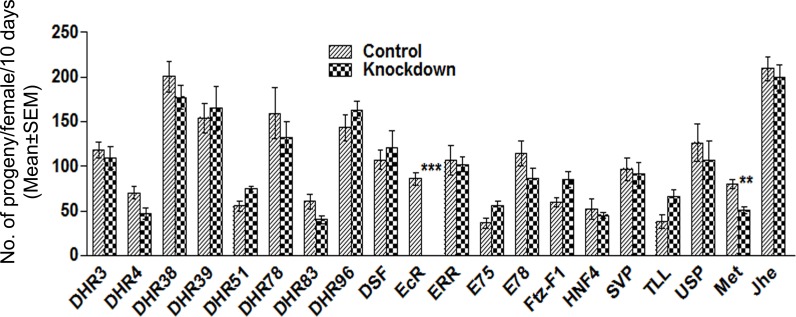
The effect of knockdown of different hormone receptors on the fertility of mated females.To identify the nuclear/hormone receptor involved in male fertility, 19 receptors were knocked down, individually, in accessory gland specific manner in the male reproductive tract and were allowed to mate with virgin females. Shown here is the number [Mean±Standard Error (SEM)] of progeny produced by females mated to knockdown or control males over a period of 10 days. Mates of met (Methoprene tolerant, a juvenile hormone receptor, **p<0.001) knockdown males produced significantly fewer progeny when compared to their controls and also those in strain background control (Jhe). Interestingly, females mated to EcR knockdown males failed to produce progeny (EcR; ***p<0.0001; Bonferroni corrected p value for significance is p<0.002). However, fertility of females mated to USP (p = 0.27) or the remaining 16 hormone receptor knockdown males was not significantly different from their respective controls. Number of females ranged from 15–45 depending on the hormone receptor analyzed.